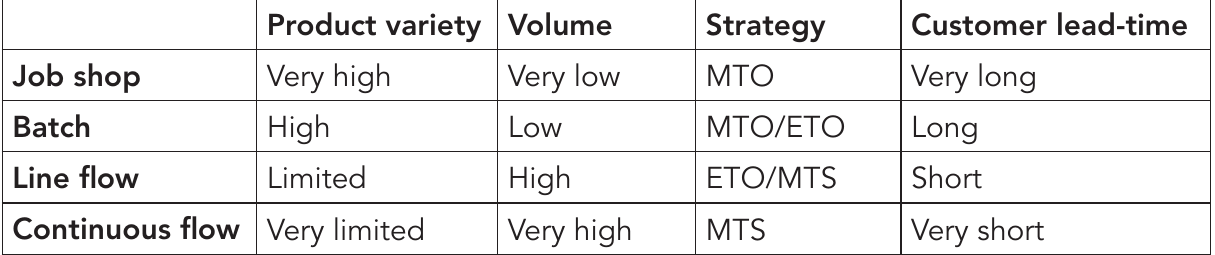
Table 2: Linking the manufacturing processes and factors Product variety Volume Strategy Customer lead-time Job shop Very high Very low MTO Very long Batch High Low MTO/ETO Long Line flow Limited High ETO/MTS